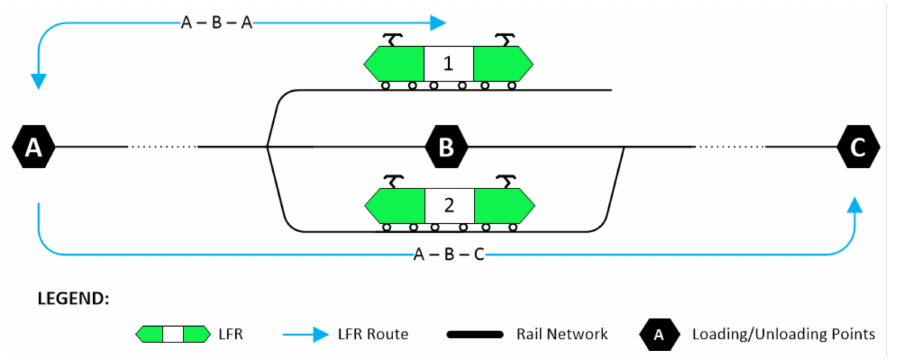
Figure 3. LFR train operation